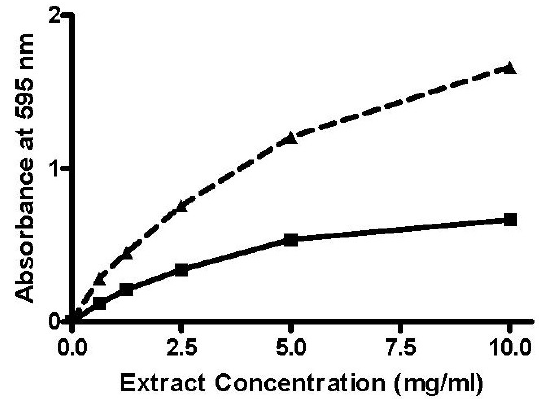
Figure 3. Concentration dependence for FRAP reaction of plant extract 2, measured after incubation for 6 min (▄) or 3 h